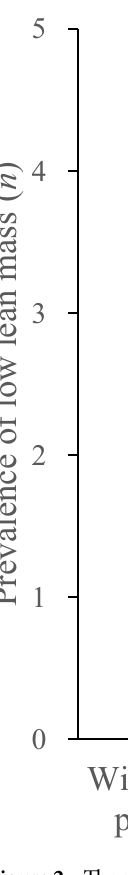
Figure 2. The number of participants with low lean mass (without and with AMD processing) according to the AWGS 2019 guidelines (men, < 7.0 kg/m 2 ; women, < 5.4 kg/m 2 ) among the 24 participants who underwent total knee replacement surgery in at least one leg. AMD automatic metal detection, AWGS Asian Working Group for